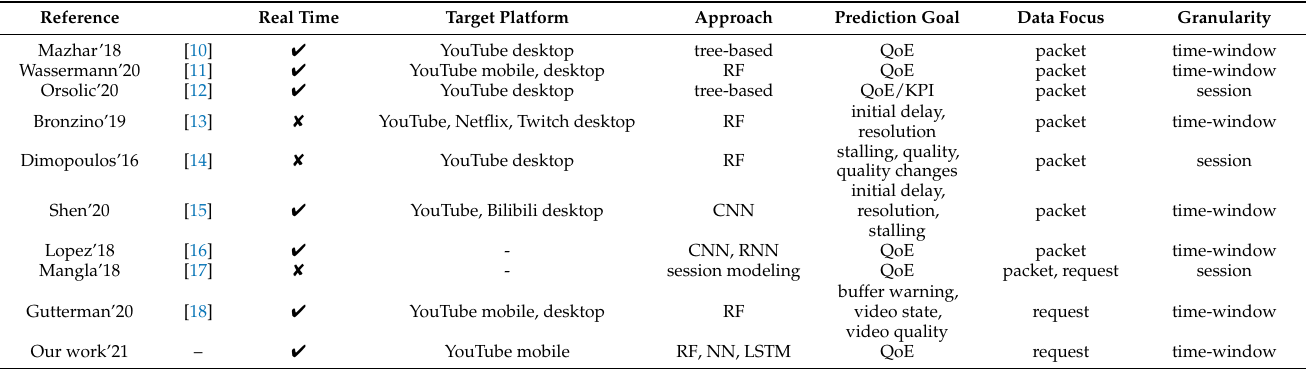
Table 1. Overview of select related